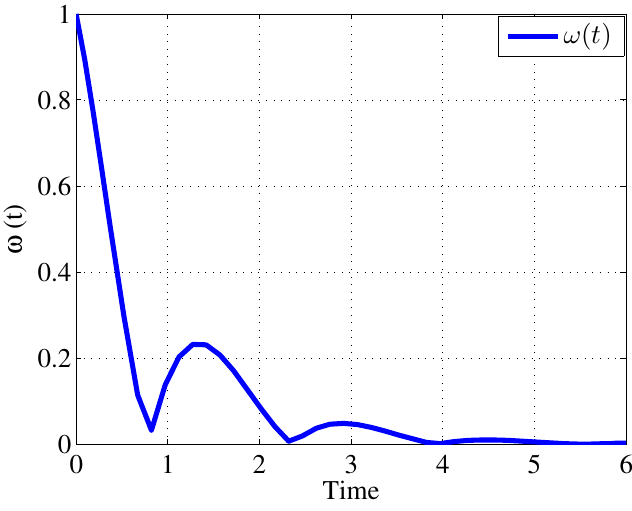
Figure 5. Disturbance ω ( t ) .